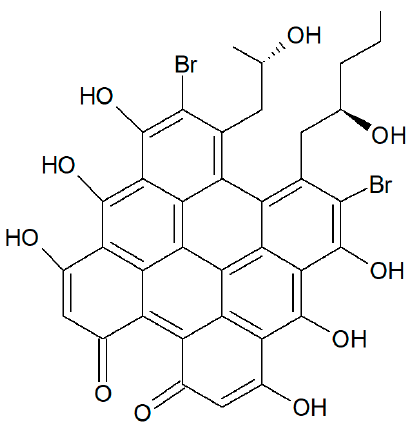
Figure 23. Structure of gymnochrome E.